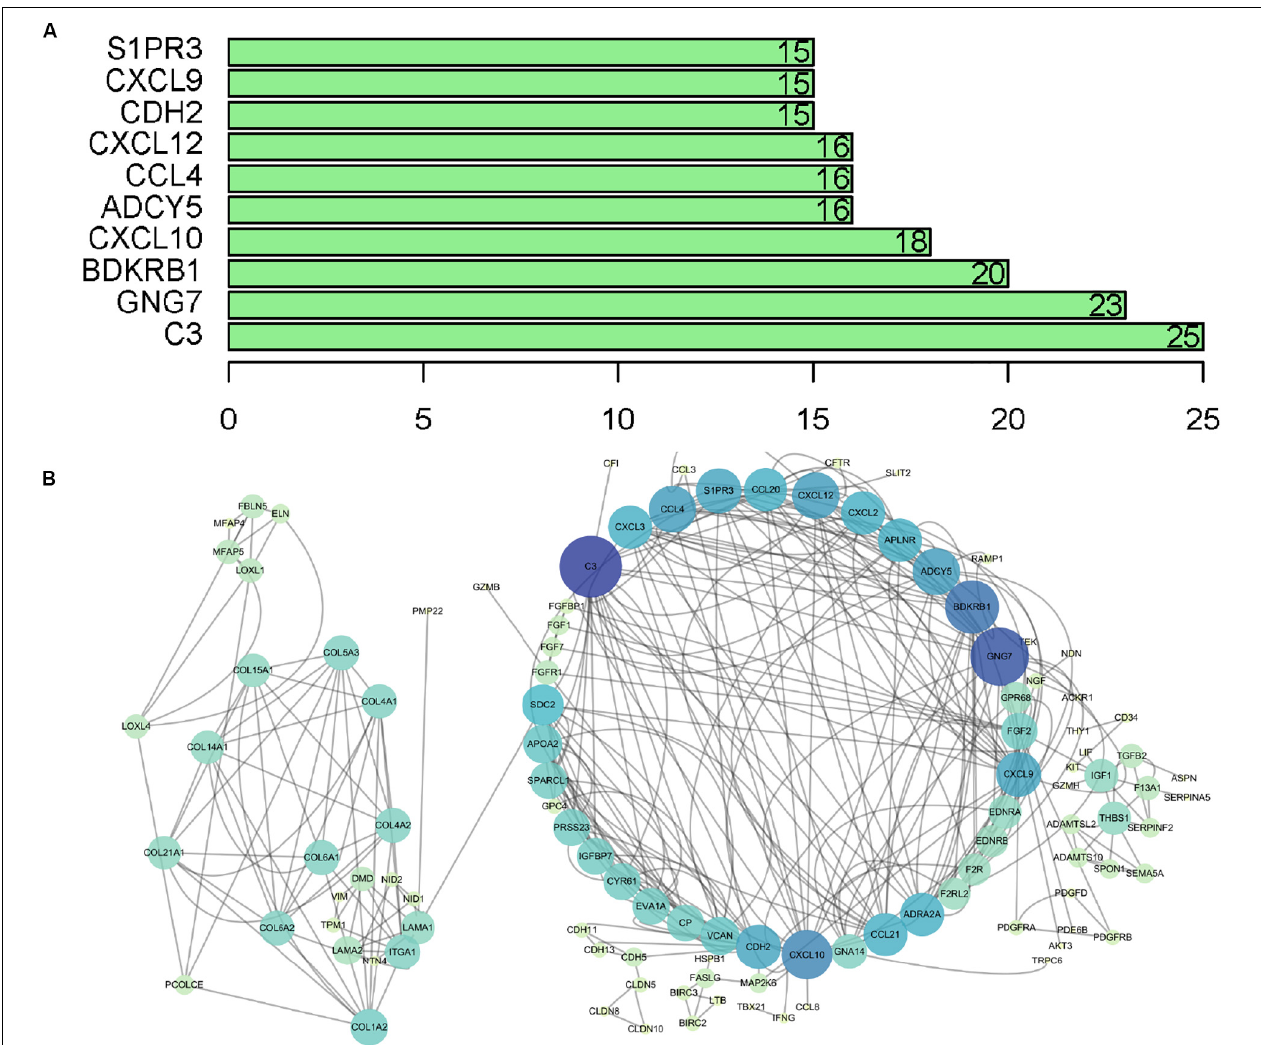
FIGURE 5 | PPI network analysis of DEGs. (A) Top 10 core genes according to nodes. (B) PPI network visualization, in which the color and size of the map nodes were determined by the degree value with a gradual process. Yellow and small circles represent low degree values, and blue and large circles represent height degree values. PPI, protein–protein